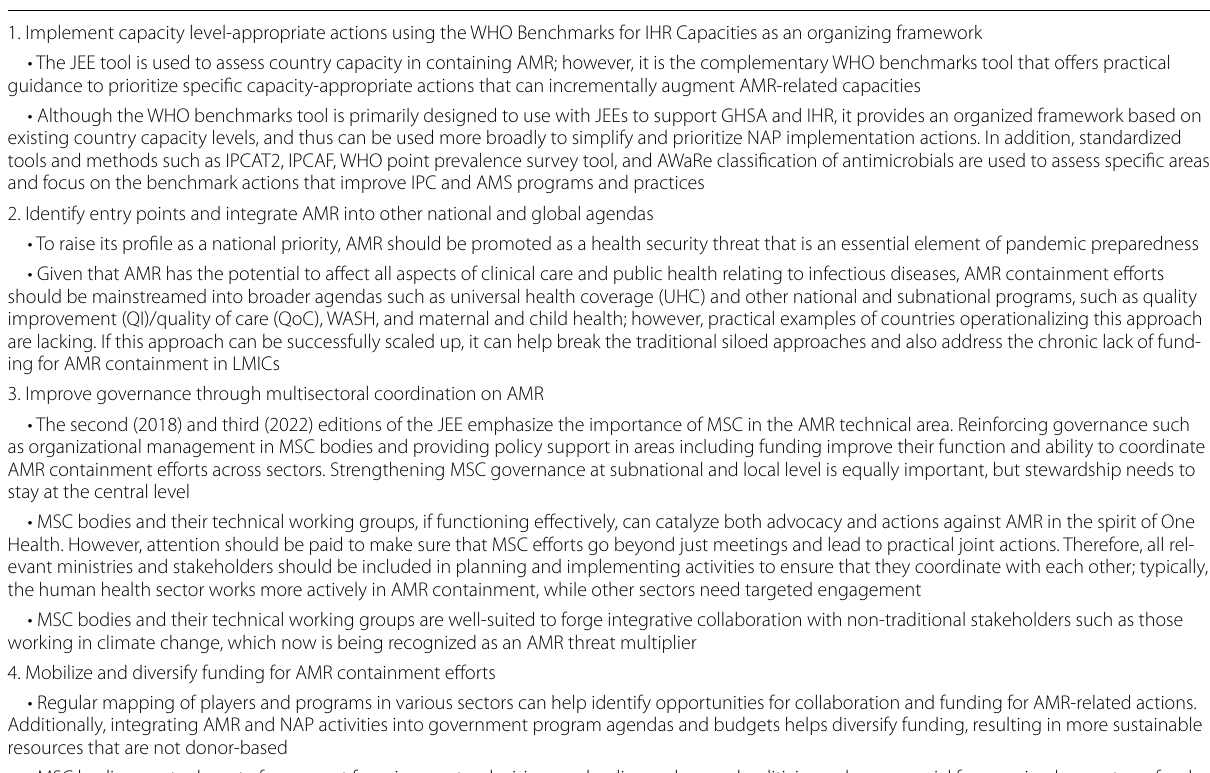
Table 4 Strengthening AMR Containment in LMICs: Four Promising Practices Highlighted through the Program’s 13-country